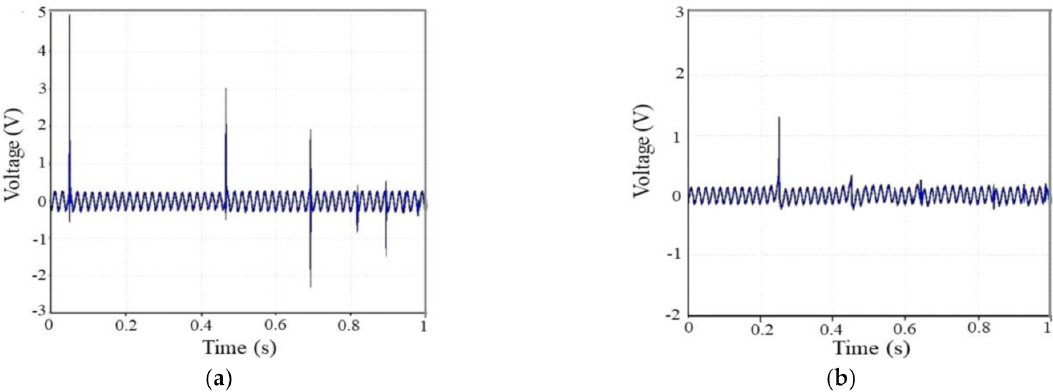
Figure 2. Response of the 250 µ m thick electrospun web drop weight impact test-excited piezoelectric nanogenerators PVDF/LiCl (0.00133 wt%) in ( a ) and pristine PVDF ( b )